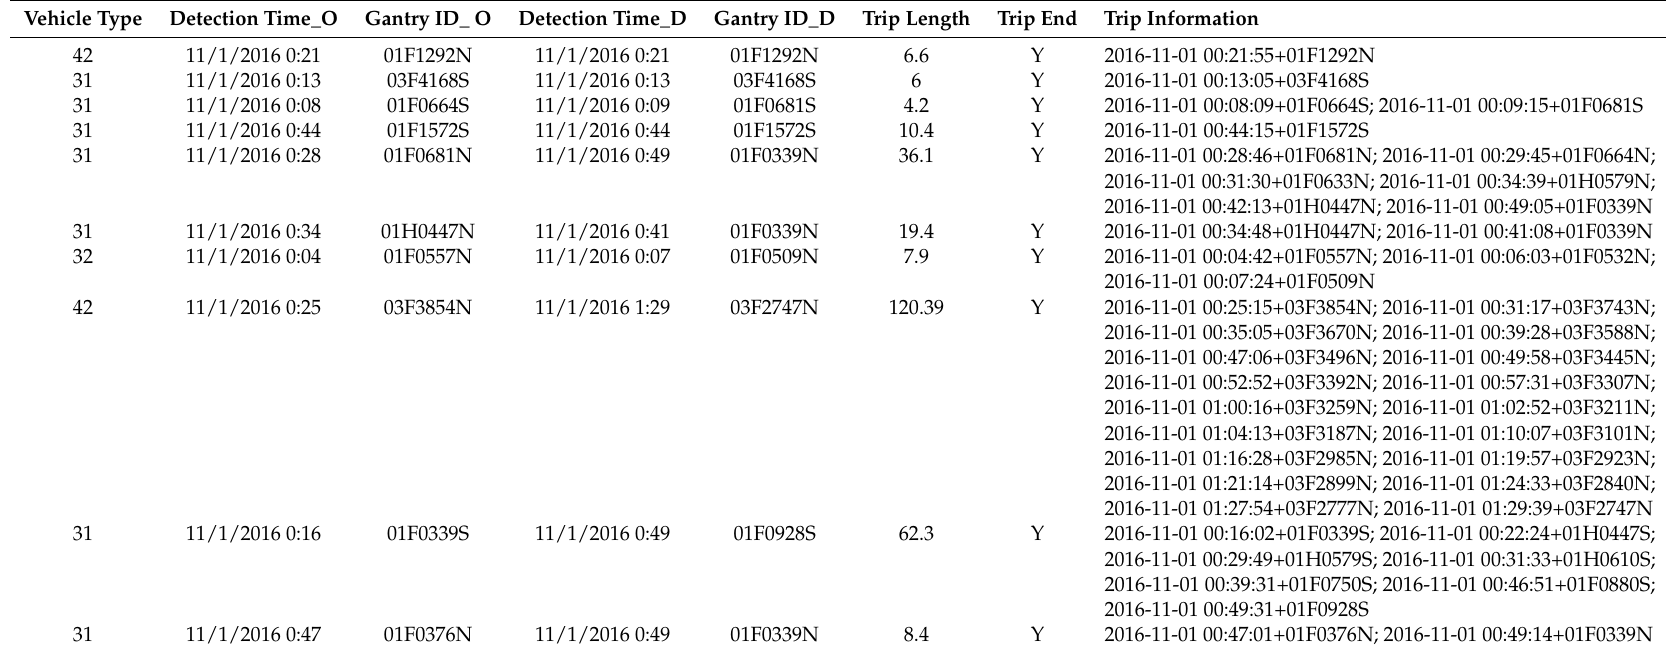
Table 2. Some records downloaded from Traffic Data Collection System